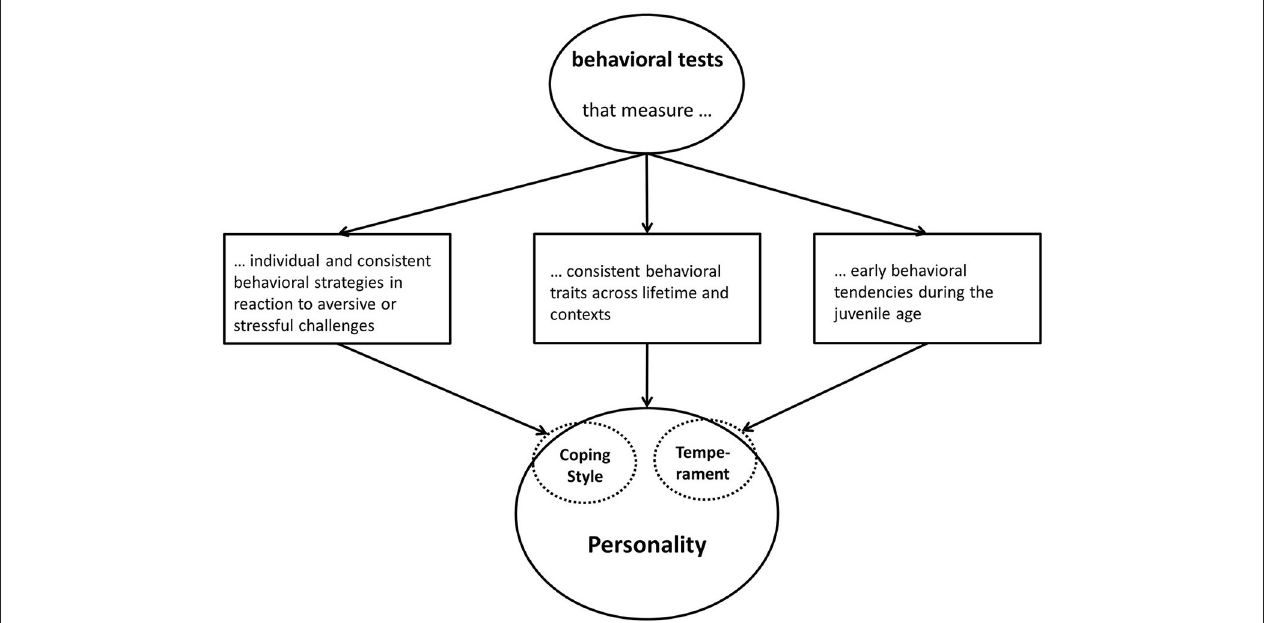
FIGURE 4 | Relationship between personality and welfare. Personality directly influences behavior and physiology and therefore influences individual welfare, while as in a feedback-loop, welfare can directly influence behavior and physiology. Behavior can influence physiology and vice versa in a sort of positive feedback system. Especially in farm animals, domestication has an impact on behavior and physiology and directly influences breeding.